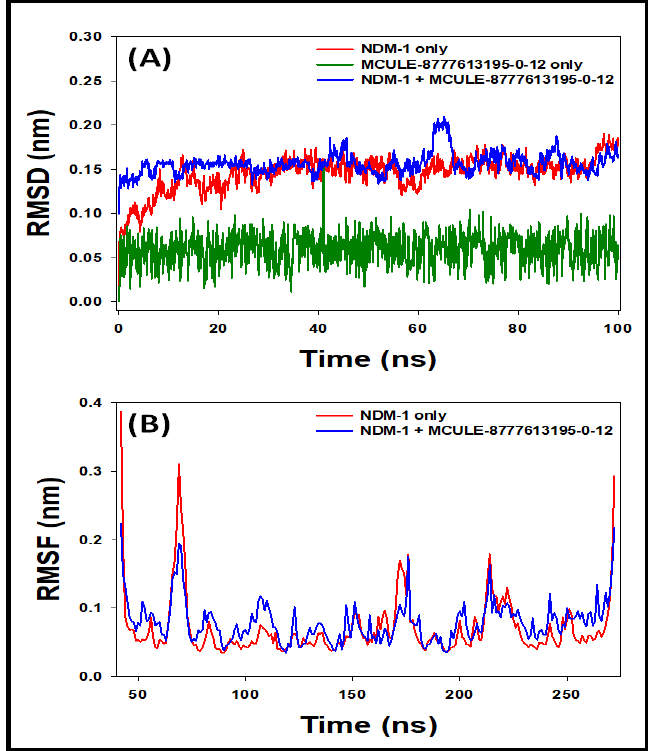
Figure 3. Molecular dynamics (MD) simulation of NDM-1 in the absence and presence of MCULE- 8777613195-0-12. ( A ) Root mean square deviation (RMSD) in the Cα -atoms of NDM-1; ( B ) root mean square fluctuation (RMSF) in the side chains of NDM-1.